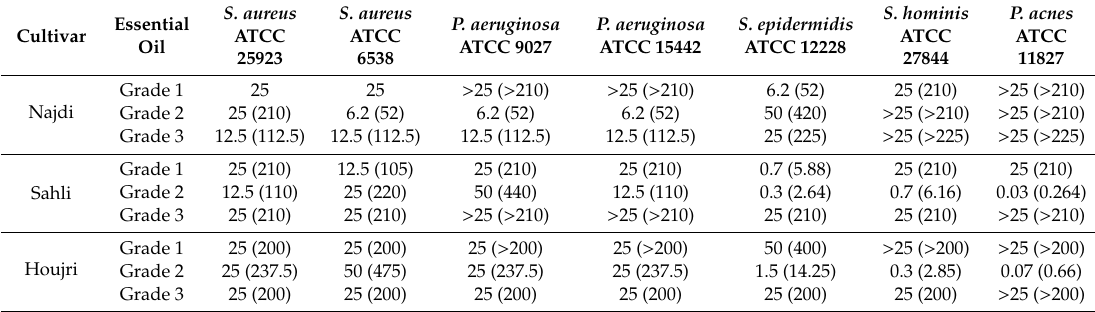
Table 3. Antibacterial activity of essential oils expressed in terms of minimum inhibitory concentration (MIC) in % v / v or mg / mL (between brackets).